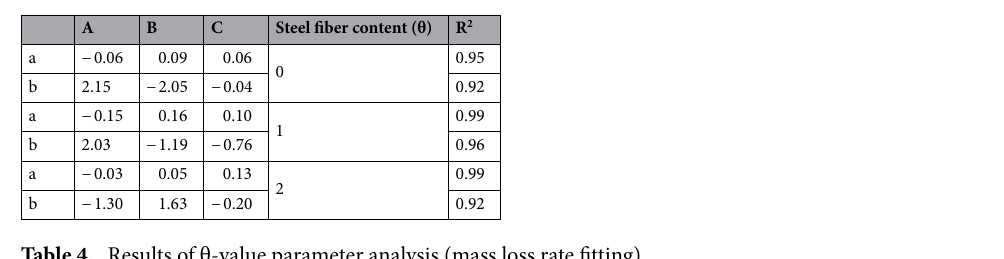
Table 4. Results of θ-value parameter analysis (mass loss rate